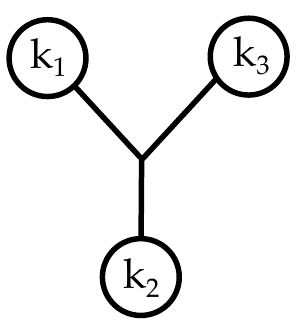
Figure 1 . Gauged Trinion: this is the quiver for T [ M 3 ; su (2)], where M 3 is a Seifert manifold over S 2 with special (cid:12)bers ( k i ; 1), i = 1 ; : : : ; 3. Here the circles denote SU(2) gauge nodes, and the labels are the Chern-Simons